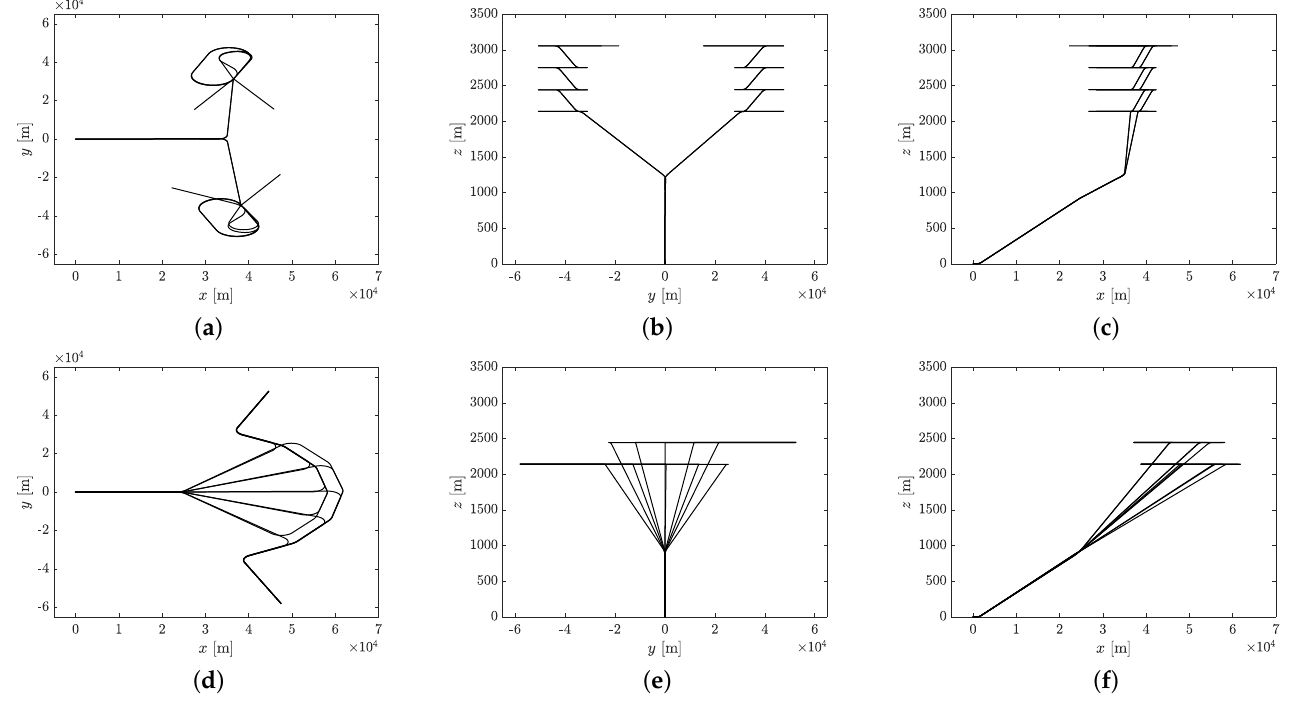
Figure A1. Flight trajectories used for the vertical holding stack (upper row) and the linear hold point merge (lower row): ( a , d ) xy profiles, ( b , e ) yz profiles, and ( c , f ) xz profiles. For the sake of brevity, only flight trajectories calculated based on the performance of the Airbus A320 are